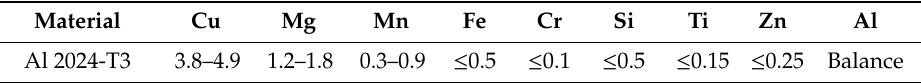
Table 1. Chemical composition of Al 2024 T3 (wt%).